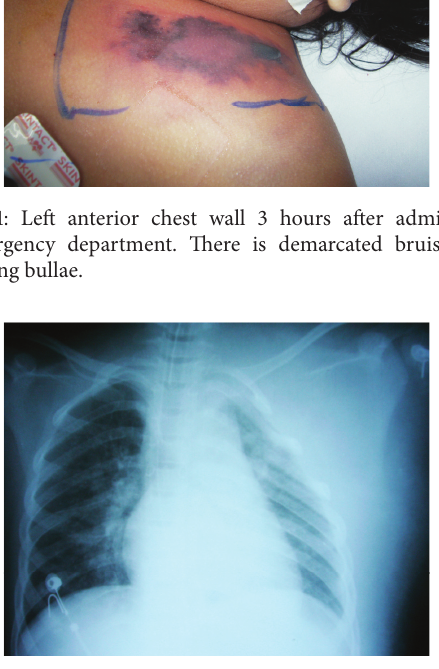
Figure 2: Chest radiograph following intubation showed left hemithorax soft tissue edema, decreased pulmonary expansion, pulmonary infiltrates, and no rib fractures.